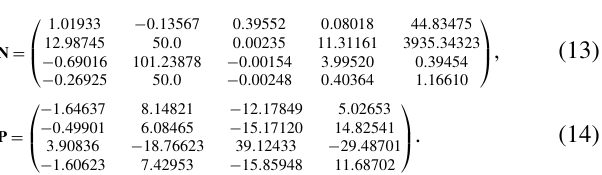
Optimal and approximated values for (cid:56) are shown for dif- ferent helix angles ranging from 0 (circular arcs) to 89 ◦ in Fig. 2. The 89 ◦ have been chosen because for 90 ◦ the inte- gral in Eq. (6) cannot be evaluated. It is shown clearly that the approximation gives a good representation of (cid:56) across the range of helix angles. There are some deviations for h/r → 1, which represents the influence of vortices close to the tip on the root sections. Because the deviations only in- fluence roughly the innermost 5 % of the rotor radius, where often no aerodynamic profiles are installed, the quality of the approximation is